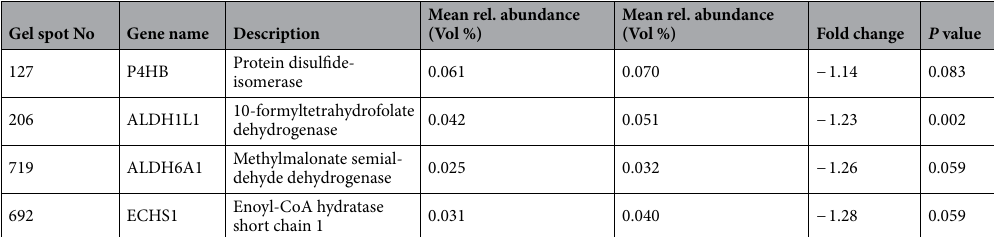
Table 4. ClueGO analysis of the liver proteome of dairy cows with high (HMU) and low milk urea concentration (LMU) fed a normal (NP) and a low dietary crude protein level (LP).